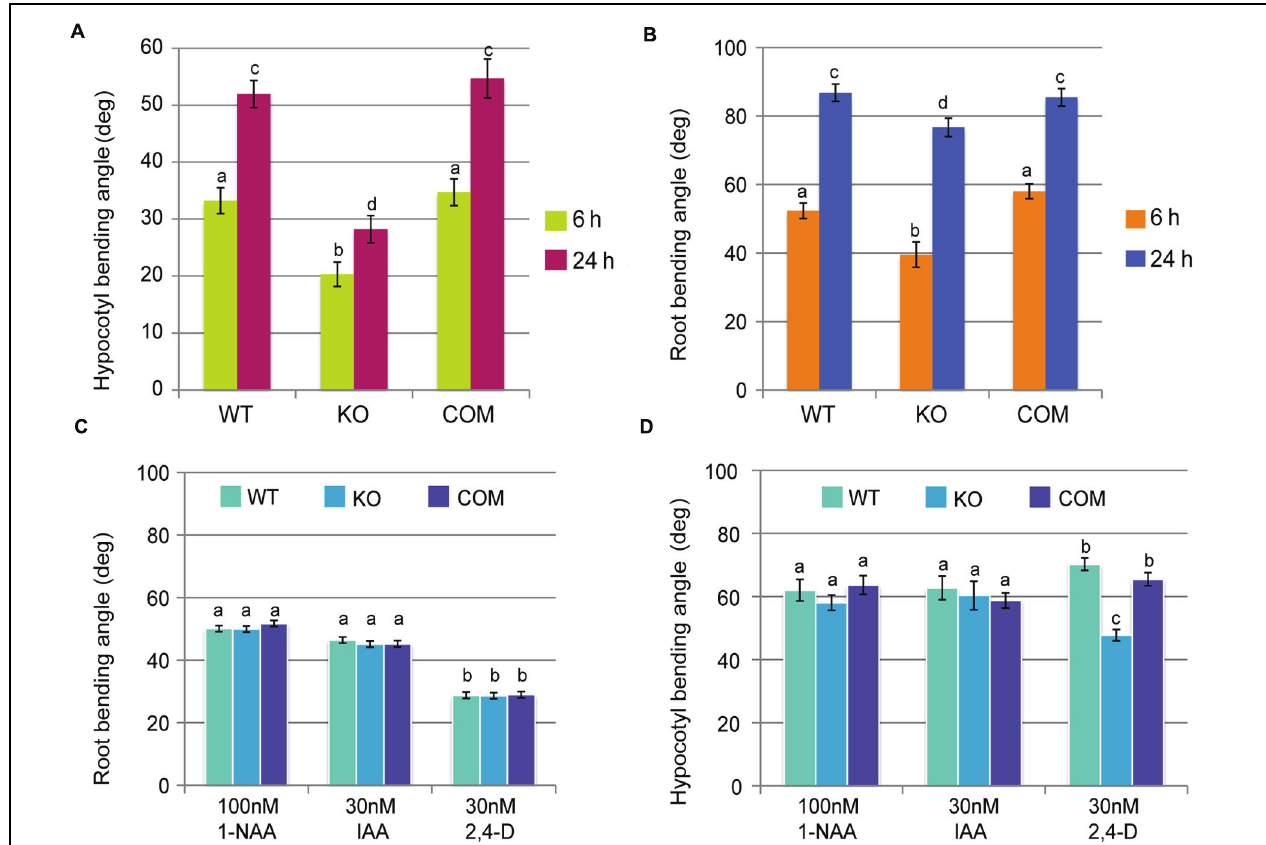
FIGURE 2 | TNO1 mediates gravitropic bending by an auxin dependent mechanism. (A) Hypocotyl bending of WT, KO and COM hypocotyls after gravistimulation. Dark-grown 5-day-old hypocotyls were gravistimulated in the dark and curvatures were calculated at 6 and 24 h after gravistimulation. (B) Root bending of WT, KO, and COM seedlings after gravistimulation. Light-grown, medium-embedded roots were gravistimulated and root curvatures were calculated at 6 and 24 h after gravistimulation. (C) Exogenous auxins can rescue the gravitropic bending defect in tno1 roots. Light-grown seedlings were overlaid with medium containing 100 mM 1-NAA, 30 nM IAA, or 30 nM 2,4-dichlorophenoxyacetic acid (2,4-D) and then gravistimulated. Root curvatures were calculated after 12 h. (D) Some exogenous auxins can rescue the gravitropic bending defect in tno1 hypocotyls. Roots of dark-grown seedlings were overlaid with medium containing 100 mM 1-NAA, 30 nM IAA, or 30 nM 2,4-D, followed by gravistimulation. Hypocotyl curvatures were calculated after 12 h. All values represent the means of three biological replicates with at least 20 seedlings for each set. Error bars indicate standard errors. Similar letters indicate no statistical difference while different letters indicate a statistically significant difference ( P < 0.05) by Student’s t